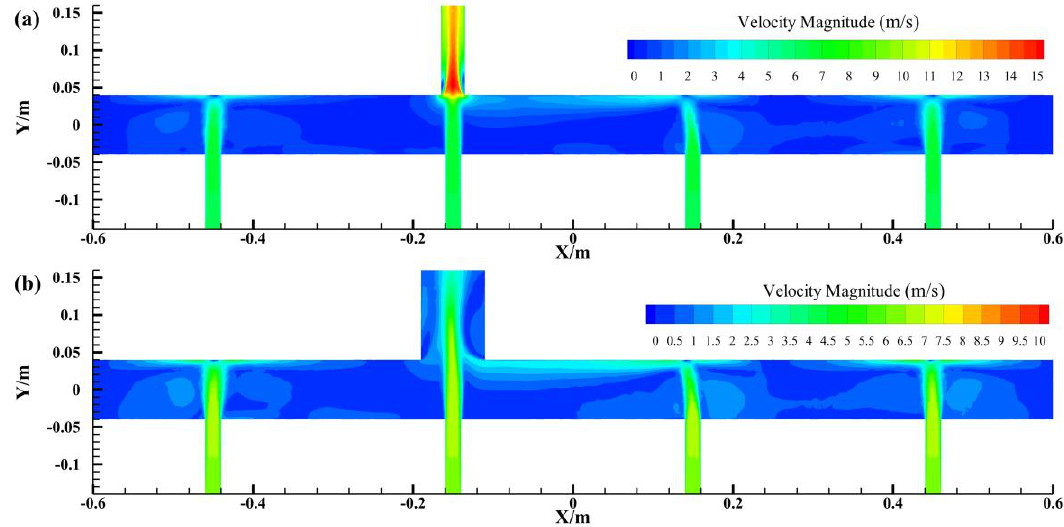
Figure 12. Velocity magnitude contours for configuration “C” cases: ( a ) AS = 0.5625; ( b ) AS = 4.